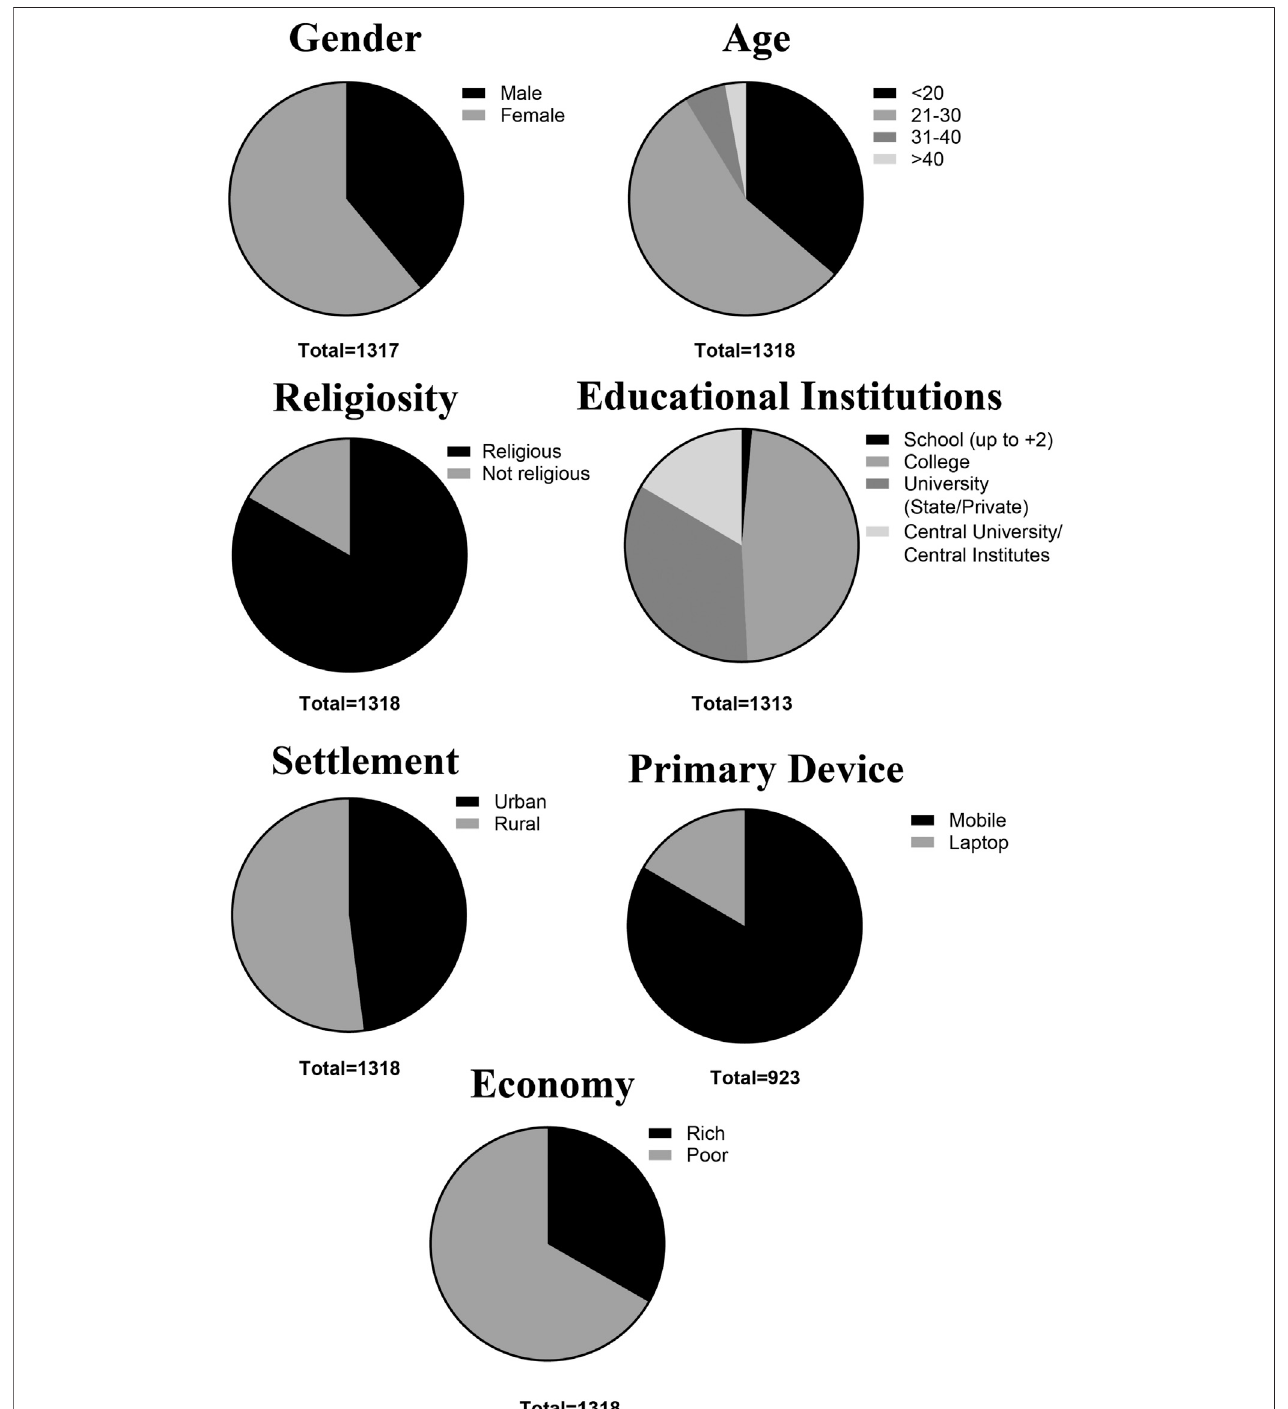
FIGURE 1 | Socio-demographic characteristics of the survey